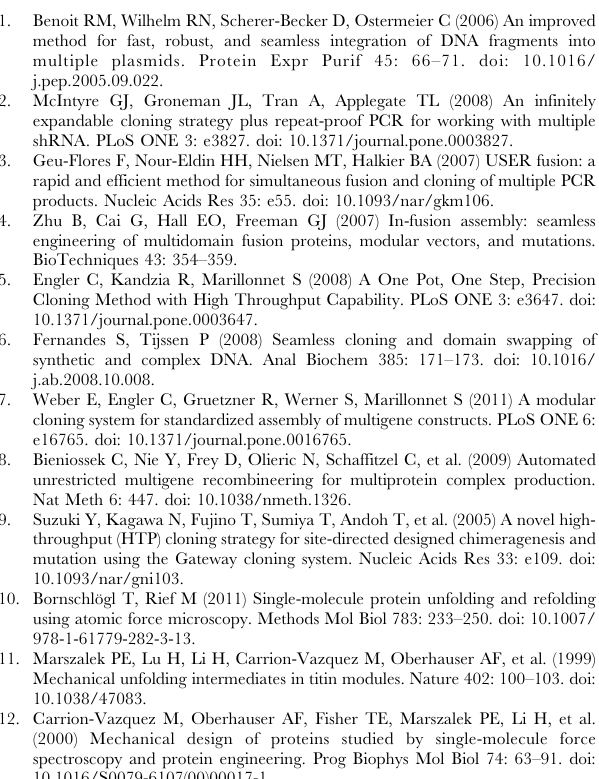
Figure S1 Western blot of (VWFA2) n in expression medium demonstrating minor contamination by con- catamers with a molecular weight different from